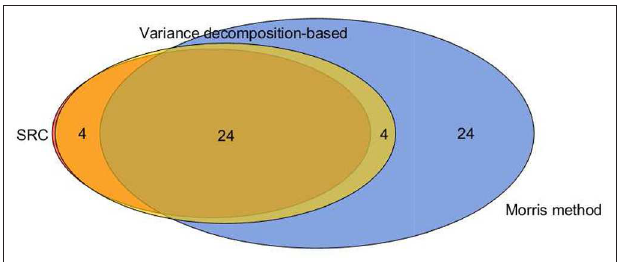
FIGURE 9 | Comparison of the important parameters selected by different sensitivity methods.